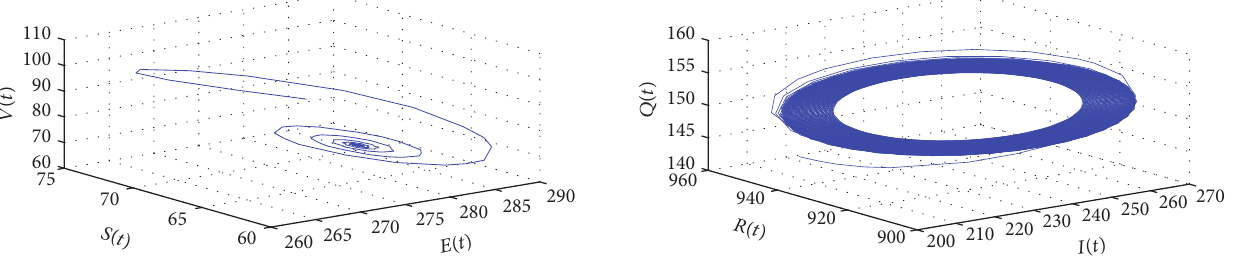
Figure 4: The projection of the phase portrait of system (69) in (𝐼, 𝑄, 𝑅) -space with 𝜏 = 4.60 . 1